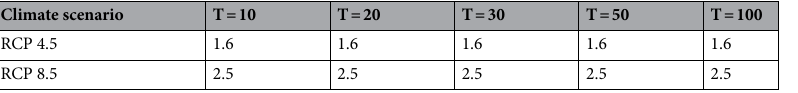
Table 4. Change of annual longest consecutive high-temperature days with five return periods (once in T years) during the period 1991–2050 in Xiongan New Area based on climate projection data (unit:d).